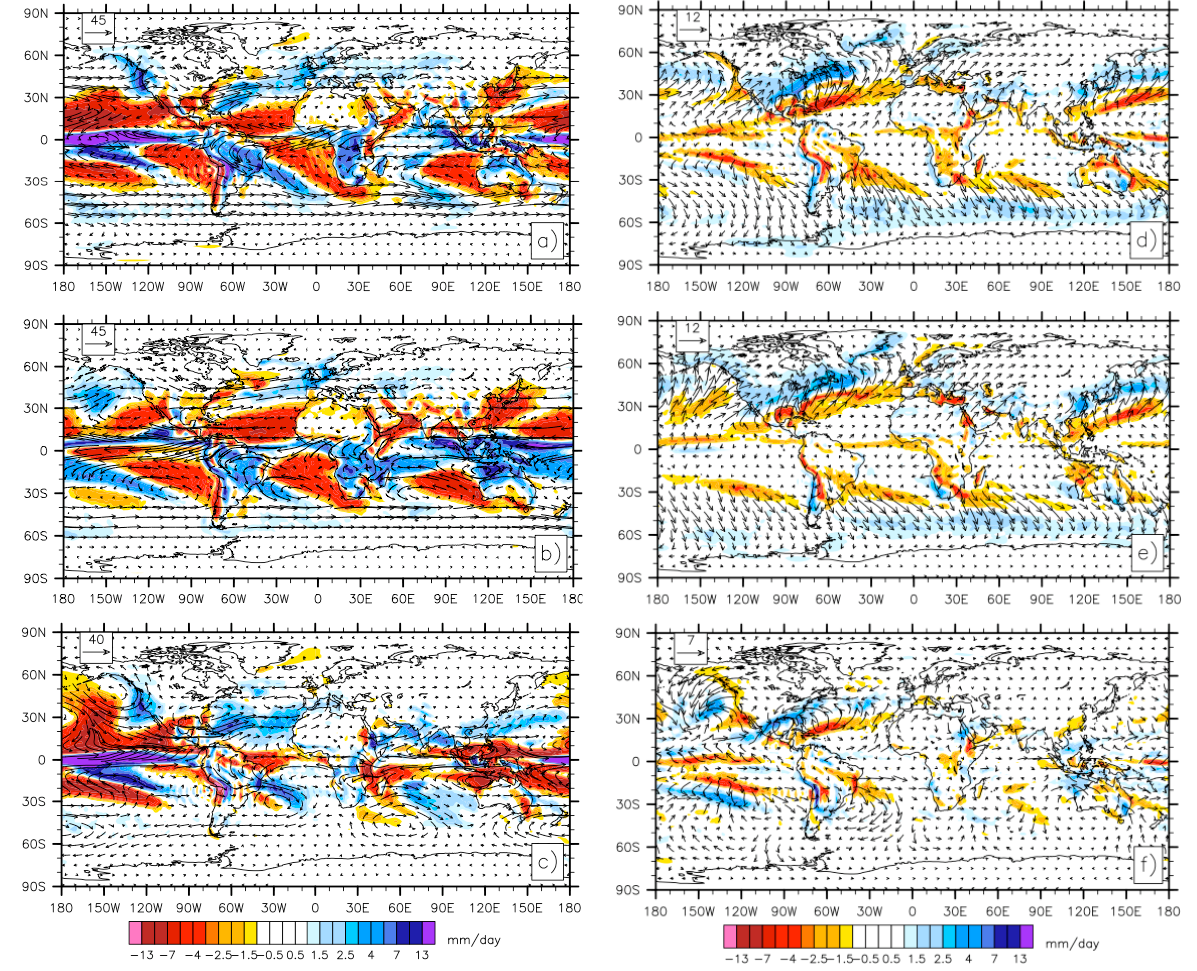
Fig. 8. Boreal winter mean vertically integrated moisture flux convergence (mmday − 1 ) with moisture transport ( ¯ U ¯ Q ) and ( ¯ V ¯ Q ) by mean winds (gkg − 1 mmday − 1 ) overlain as vectors on the 850 mb pressure surface. (a) Mean vertically integrated moisture flux convergence for NINO case, (b) Mean integrated moisture flux convergence for MODERN case, and (c) Mean vertically integrated moisture flux convergence anomaly for NINO minus MODERN. Boreal winter transient eddy vertically integrated moisture flux convergence (mmday − 1 ) with moisture flux by transient eddies ( U 0 Q 0 ) and ( V 0 Q 0 ) (gkg − 1 mmday − 1 ) overlain as vectors on the 850mb pressure surface. (d) Transient eddy vertically integrated moisture flux convergence for NINO case, (e) Transient eddy integrated moisture flux convergence for MODERN case, and (f) Transient eddy vertically integrated moisture flux convergence anomaly for NINO minus